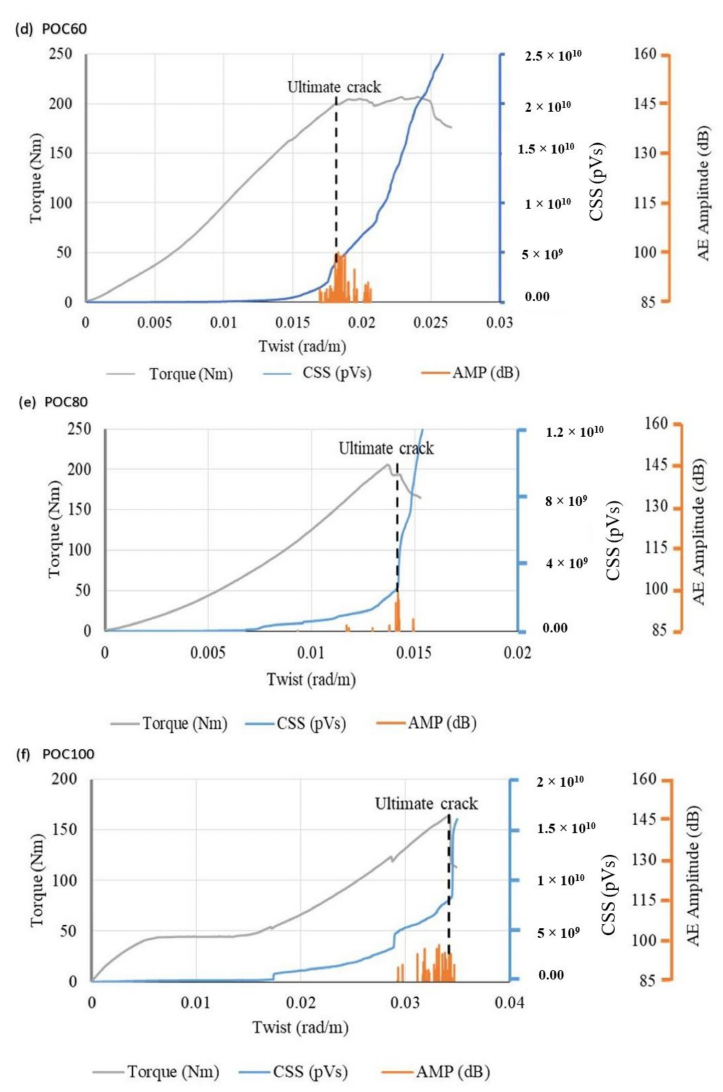
Figure 8. CSS, AE amplitude, and torque versus angle of twist graphs for ( a ) 0%, ( b ) 20%, ( c ) 40%, ( d ) 60%, ( e ) 80%, and ( f ) 100% replacement levels of POC coarse